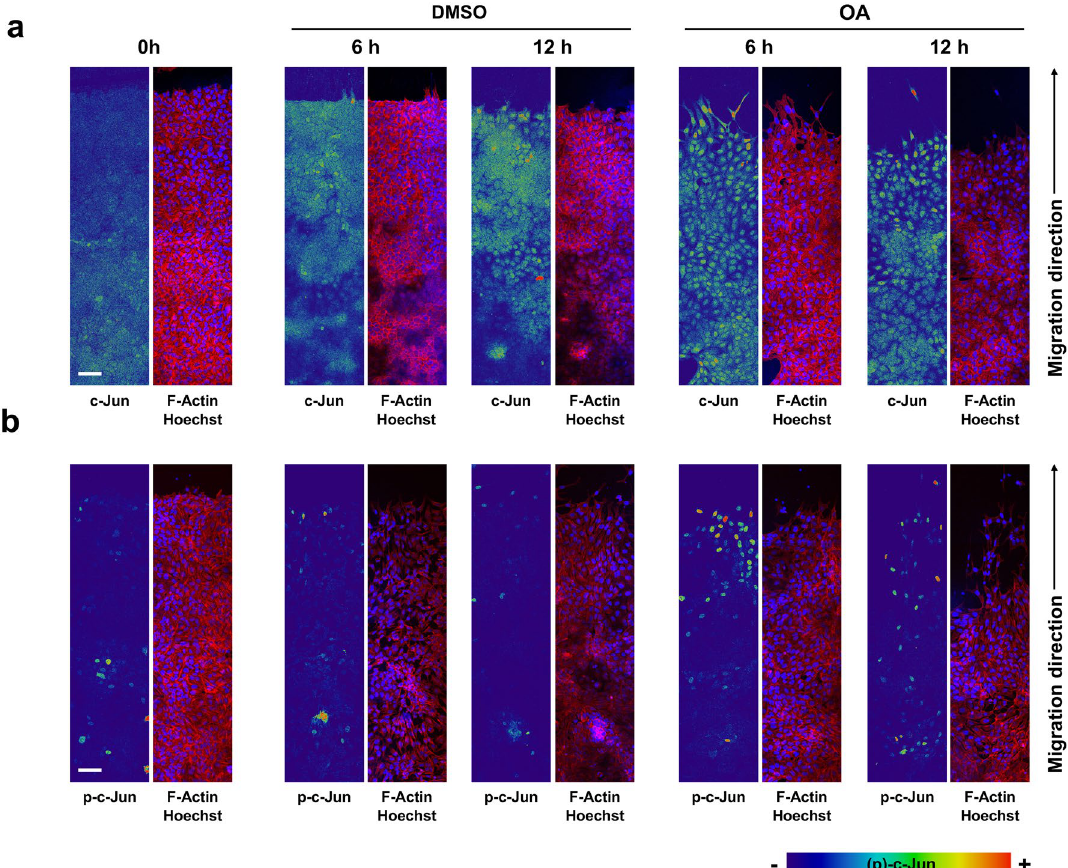
Figure 1. Oleanolic acid induces the expression of c-Jun and promotes its phosphorylation at the edge of wound-scratched Mv1Lu cells. Confluent Mv1Lu cells were scratched and allowed to migrate for the indicated times. Cells were treated with 5 µM OA or DMSO equivalent volume (control). Cells were immunostained with specific antibodies against c-Jun ( a ) and its active phosphorylated form, p-c-Jun ( b ). Co-staining with phalloidin and Hoechst-33258 was used to show actin cytoskeleton and nuclei, respectively. Images of c-Jun/p-c-Jun fluorescence were converted into pseudo-color with ImageJ software to show the intensity of c-Jun staining. Color rainbow scale represents fluorescence intensity for either c-Jun or phospho-c-Jun. Actin fibers (F-actin): red. Nuclei: blue. Images were obtained with a confocal microscope. This experiment was repeated at least three times. Representative images are shown. Scale bar indicates 50